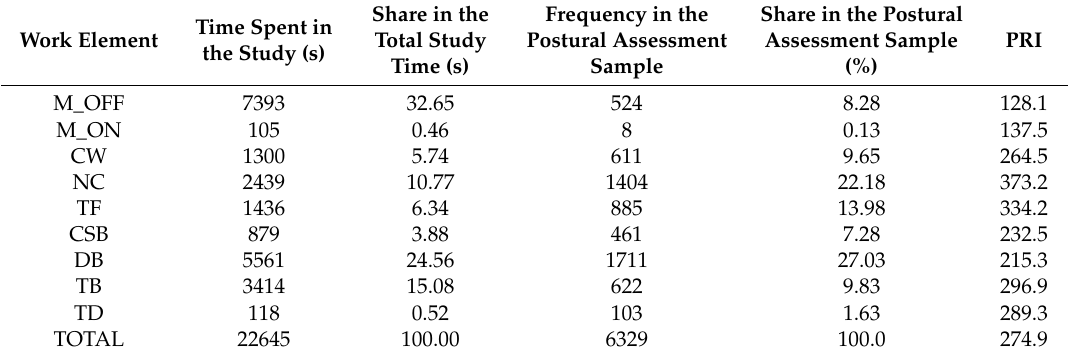
Table 6. Postural risk index assessment of motor-manual tree felling and processing.